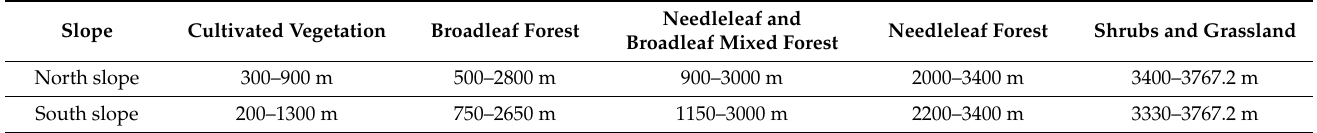
Table 2. Ranges of elevation values for different vegetation groups in Taibai Mountain.